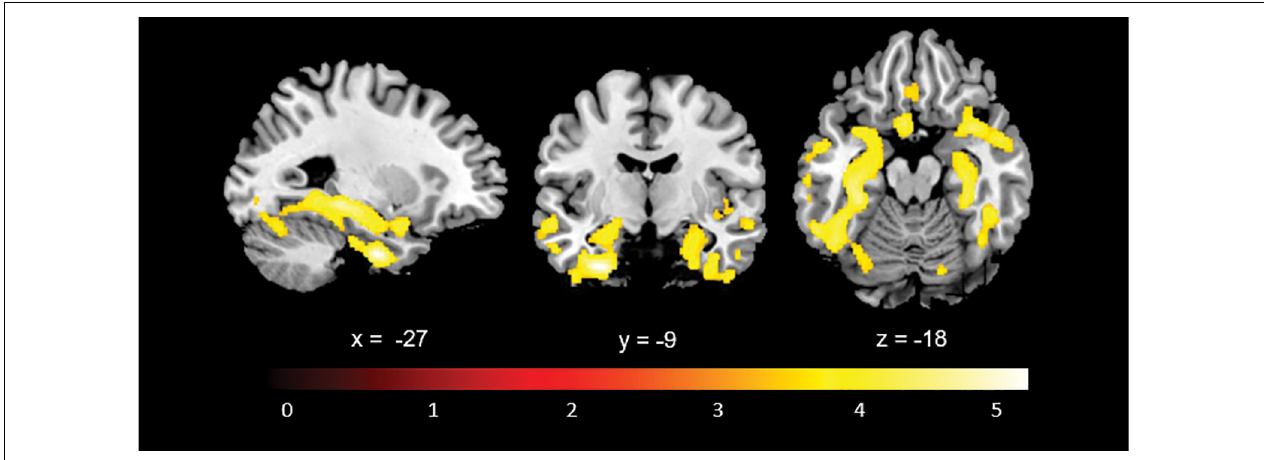
FIGURE 1 | Statistical whole-brain grey matter volumetric comparison between the participant sample ( n = 46) and a control group ( n = 34) showing atrophy in medial temporal lobe structures consistent with a probable AD aetiology.